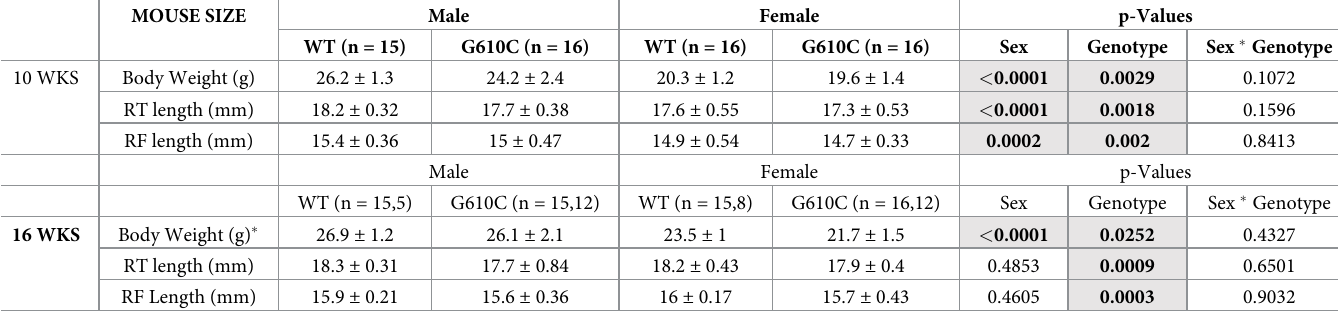
� Body weight data for the first round of sacced mice were lost. (n = a,b) indicates sample size for a = overall, b = body weight. Data presented as mean +/- standard